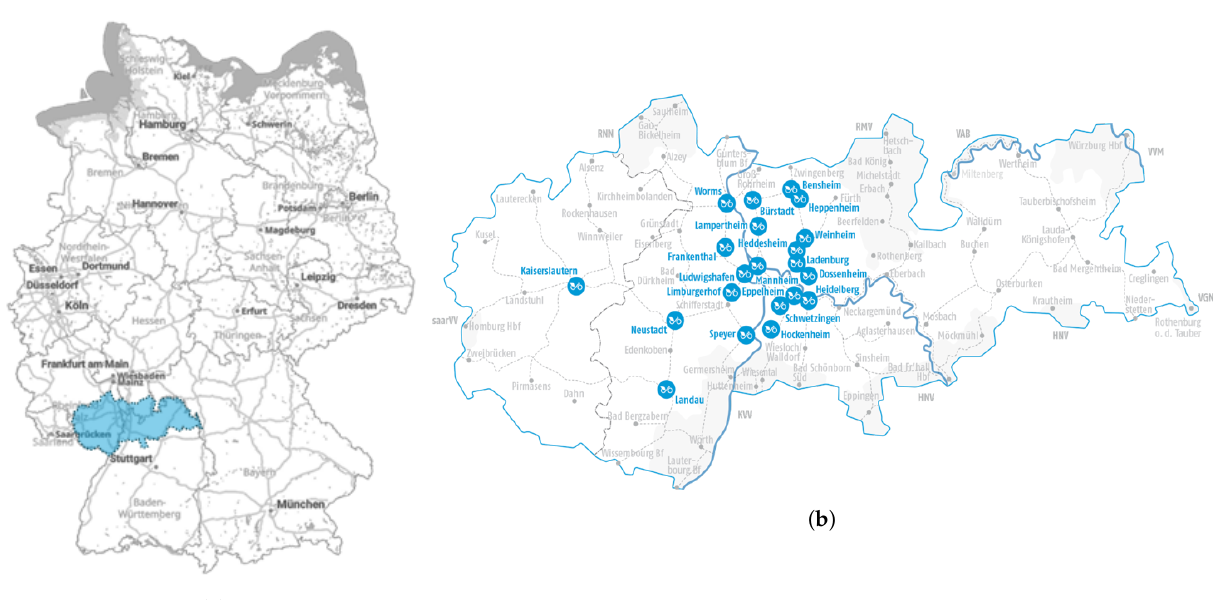
Figure 1. Geographical location and supply area of VRNnextbike. The system operates in three federal states (Rhineland-Palatinate, Hesse and Baden-Wuerttemberg). ( a ) Geographical location of the VRNnextbike area. ( b ) Detailed view of the VRNnextbike